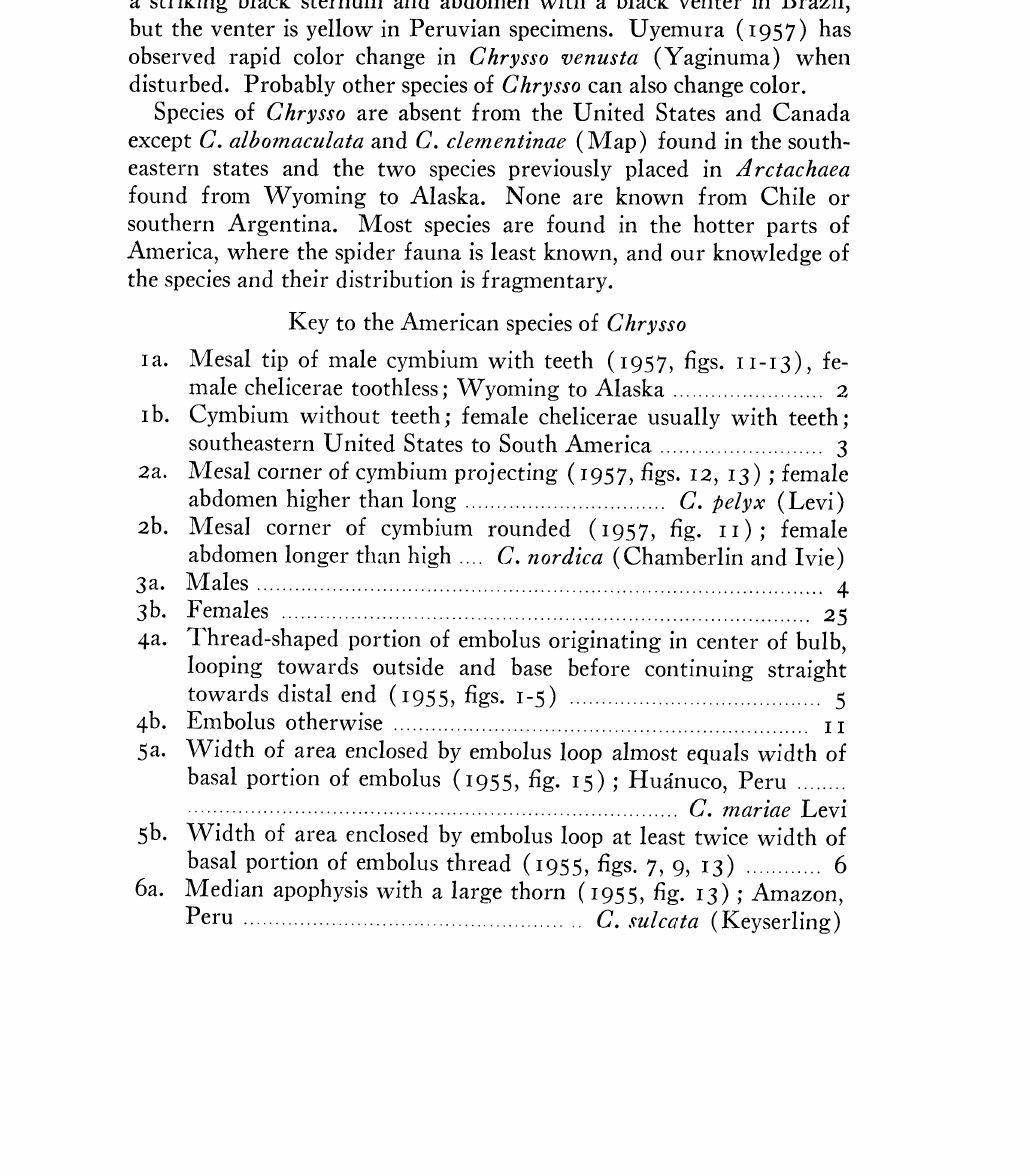
Thread-shaped portion of embolus originating in center of bulb, looping towards outside and base before continuing straight towards distal end (1955, figs. I-5) 5 Embolus otherwise Width of area enclosed by embolus loop almost equals width of basal portion of embolus (1955, fig. I5) Huinuco,